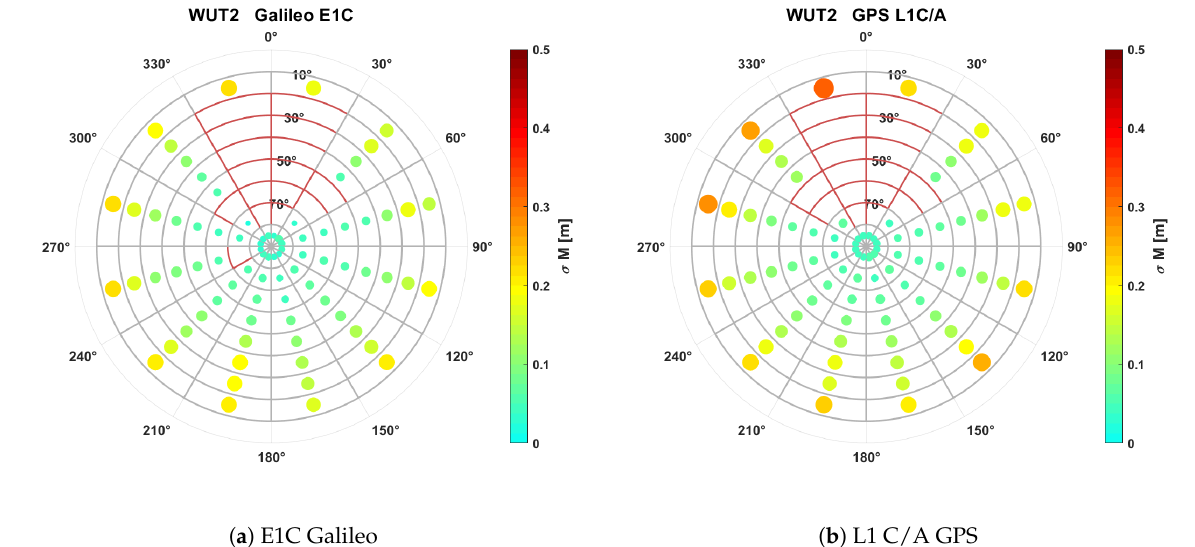
Figure 5. Three-dimensional distribution of a code multipath error at the WUT2 site for ( a ) E1C Galileo and ( b ) L1 C/A GPS